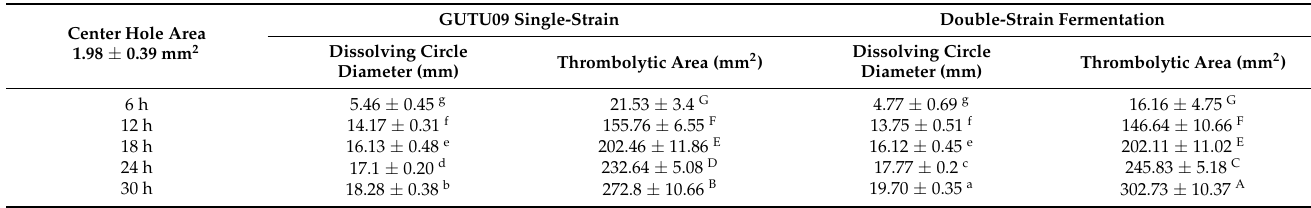
Figure 7. ( A 1 , A 2 ) Comparison of the effect of single-bacteria and mixed-bacteria fermented natto on fibrin plate dissolution circle; ( B ) changes in nattokinase activity during fermentation; ( C ) prothrom- bin condensation inhibition ability. Table 4. Changes in fibrinolytic activity during